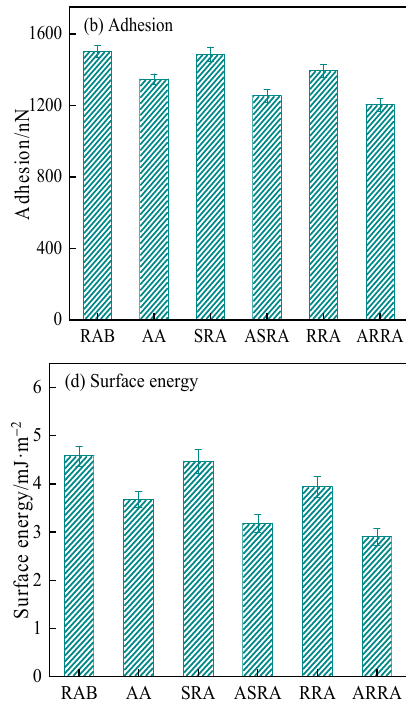
( f ) Figure 7. Micromorphology of asphalt binders: ( a ) RAB; ( b ) AA; ( c ) SRA; ( d ) ASRA; ( e ) RRA; ( f ) ARRA. The number of bee-shaped structures in the raw asphalt is large, and the single area of bee-shaped structures is small. After aging and recycling, the number of bee-shaped structures decreases, and the area of a single bee-shaped structure increases due to the reduced compatibility between the crystalline fraction and the more polar matrix phase [28]. The phenomenon above indicates that aging and recycling without a rejuvenating agent promote the further development of bee-shaped structures [17]. Furthermore, there